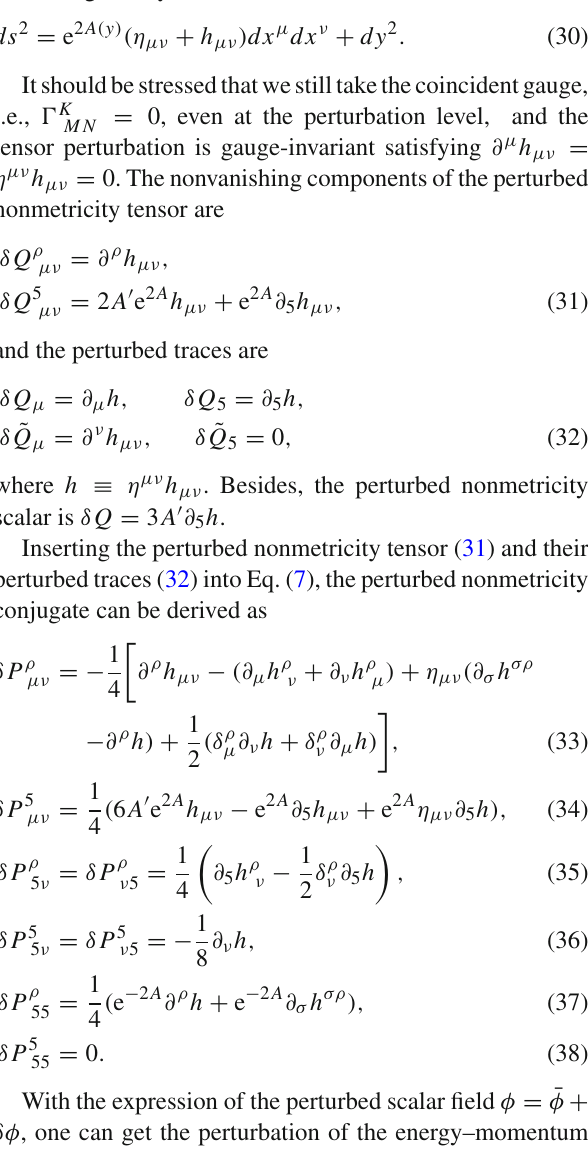
Fig. 2 Theshapesofthewarpfactore 2 A ,backgroundscalarfield φ( y ) , scalar potential V (φ) , and energy density ρ( y ) for the second brane solutions. The parameters are set to k = κ = 1, c = 6 for blue short dashed lines, c = 7 for black lines, and c = 8 for red long dashed lines the spacetimes for both brane systems are asymptotic anti-de Sitter along the fifth